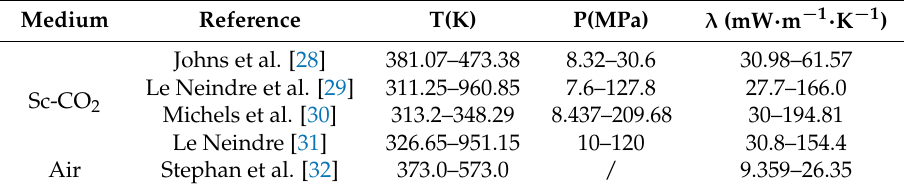
Table 1. Summary of the thermal conductivity data of supercritical carbon dioxide (Sc-CO 2 ) and air in different studies.